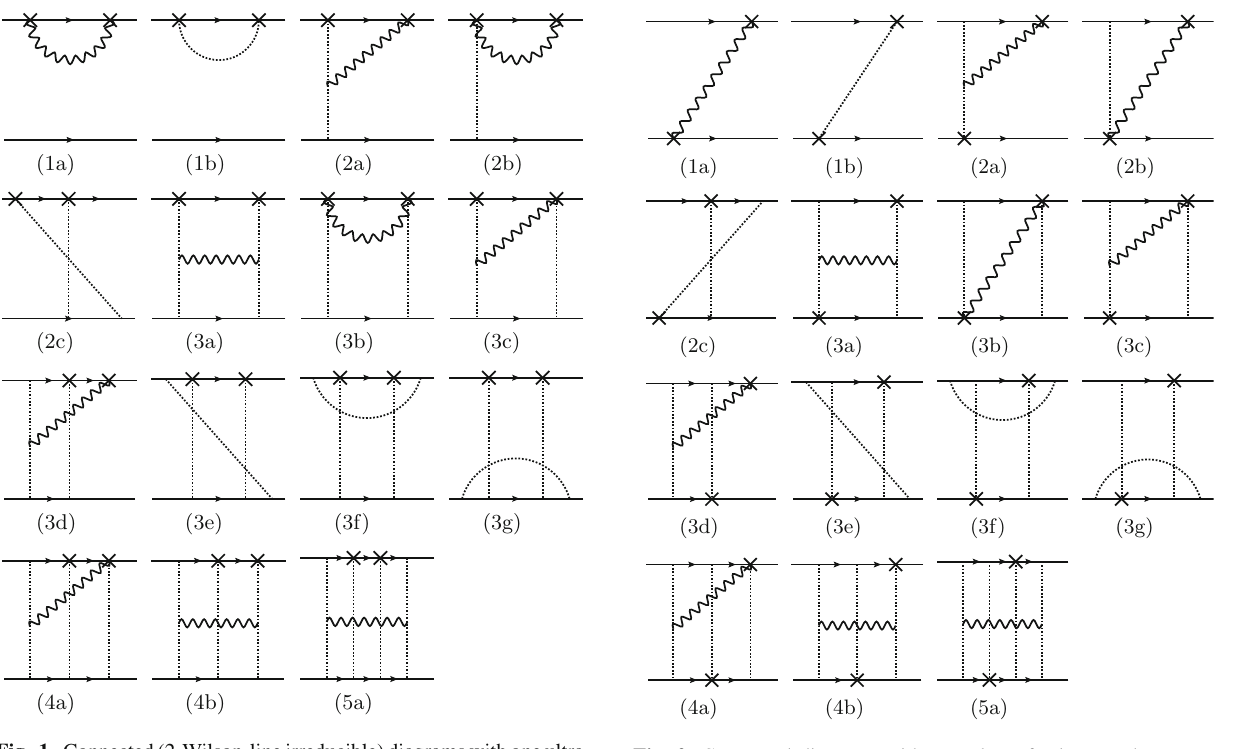
Fig. 1 Connected (2-Wilson-line irreducible) diagrams withone ultra- Fig. 2 Connected diagrams with one ultrasoft gluon exchange con- ( 2 , 0 ) ( 1 , 0 ) ( 1 , 1 ) and E . Left–right mirror soft gluon exchange contributing to E . Left–right mirror graphs are understood. As tributing to E US US US graphs are understood. Dotted lines represent the A 0 , wiggled lines the explained in the text, the diagrams are in one-to-one correspondence, A components of a gluon. The time axis in these diagrams extends from and in fact equal, to the ones of Fig. 1 left to right. The crosses symbolize the chromo-electric operator inser- tions at times 0 and t on the upper Wilson line (solid). Vertical lines are associated with potential gluons. The ultrasoft gluon is depicted as diagonal, horizontal or curvy line. We adopt the NRQCD convention for the fermion flow (little arrows on the Wilson lines) explained in Fig. 3. Diagrams ( 1 b ) , ( 2 c ) , ( 3 e ) , ( 3 f ) , ( 3 g ) vanish in Coulomb gauge